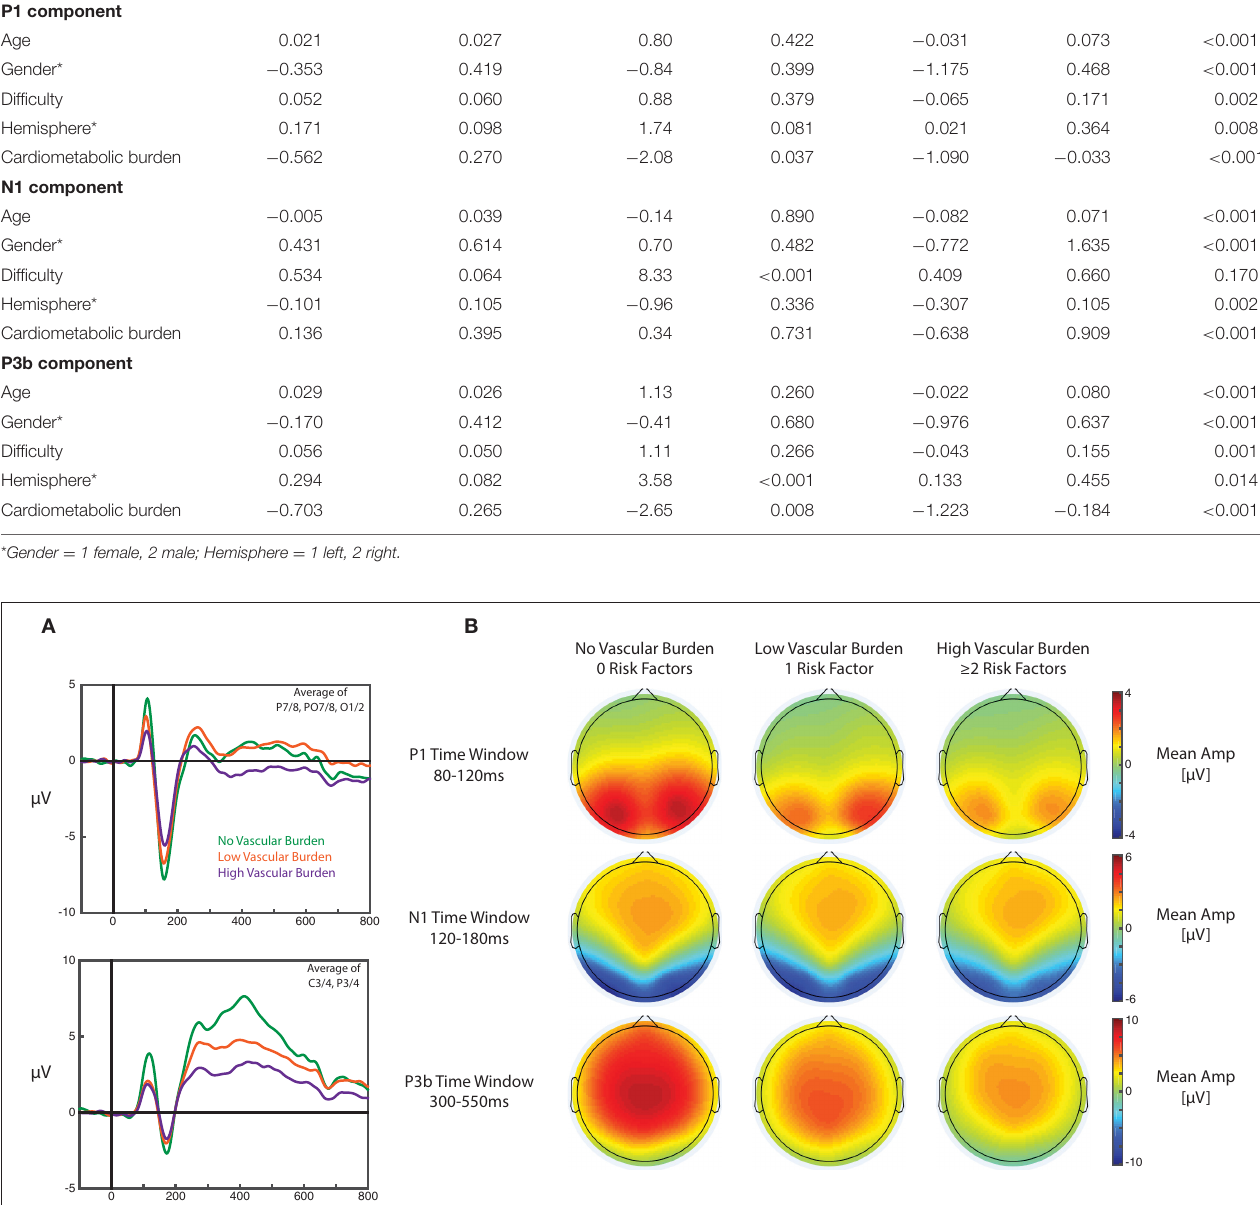
(52)], our results also suggest caution when comparing P3b amplitudes across groups with different cardiometabolic